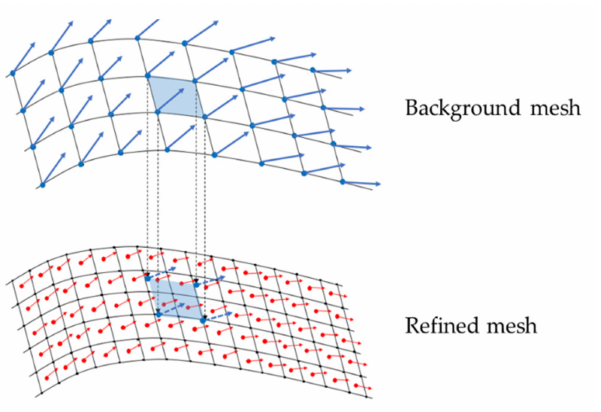
Figure 1. A sketch of the mesh refinement ( top : the background mesh; bottom : the refine